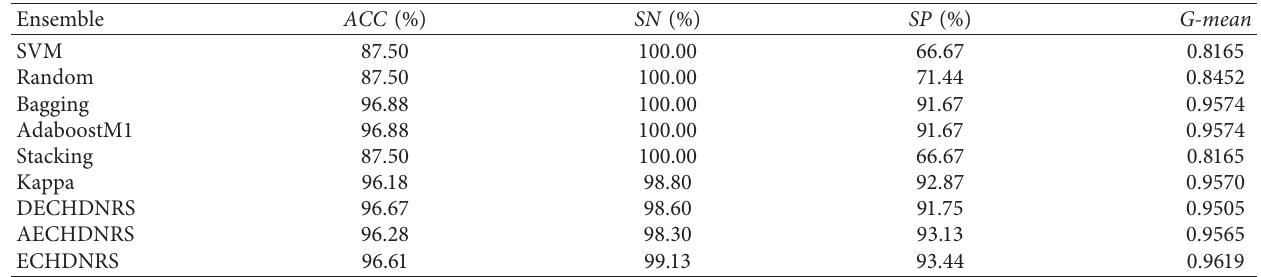
Table 6: Classification results on Arabidopsis -Oxygen dataset.